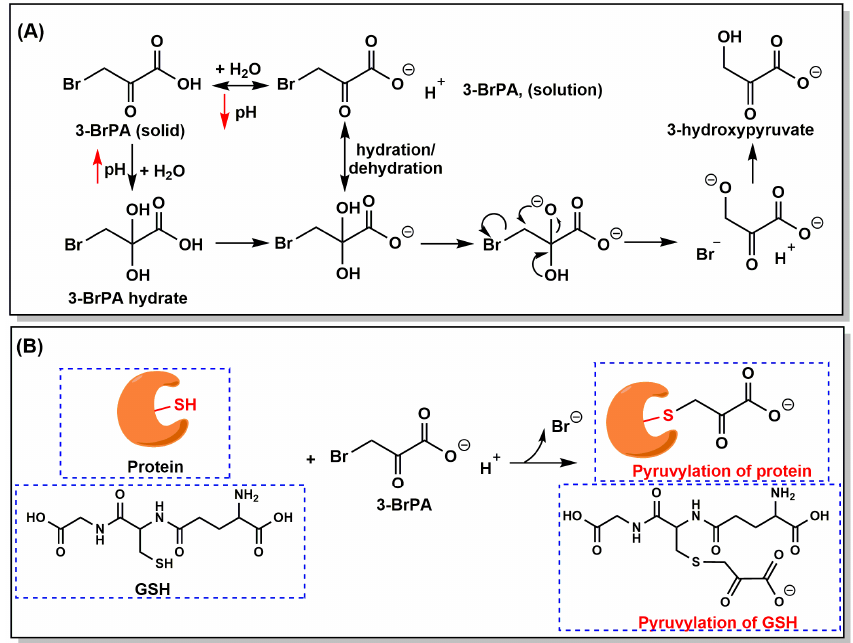
Figure 4. Structure, decomposition, and mechanism of action of 3-BrPA. ( A ) Proposed mechanism of decomposition in solutions with different pH values. ( B ) Modification or inactivation of proteins, enzymes, or glutathione by 3-BrPA through the covalent binding of a pyruvic moiety to the thiol groups (especially the –SH group) of targets.